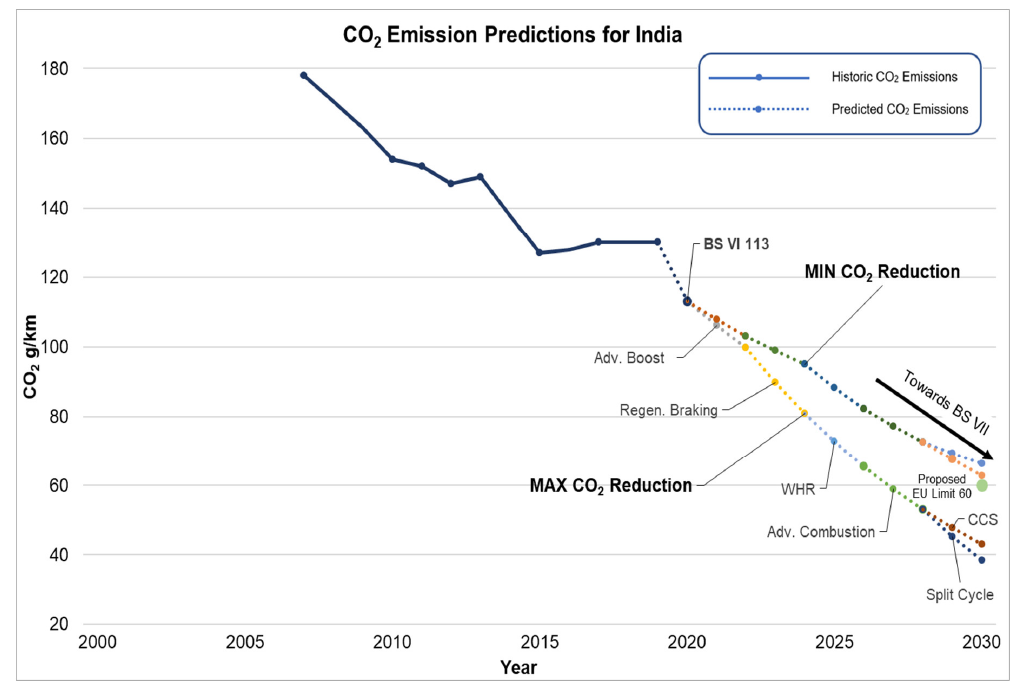
Figure 6. Historic CO 2 emissions for transportation in India. The values plotted on the graph are for the diesel emissions limits for India starting from 2007 to 2020. The calculated reduction of predicted emissions was plotted until the year 2030 and are illustrated in Figure 7.